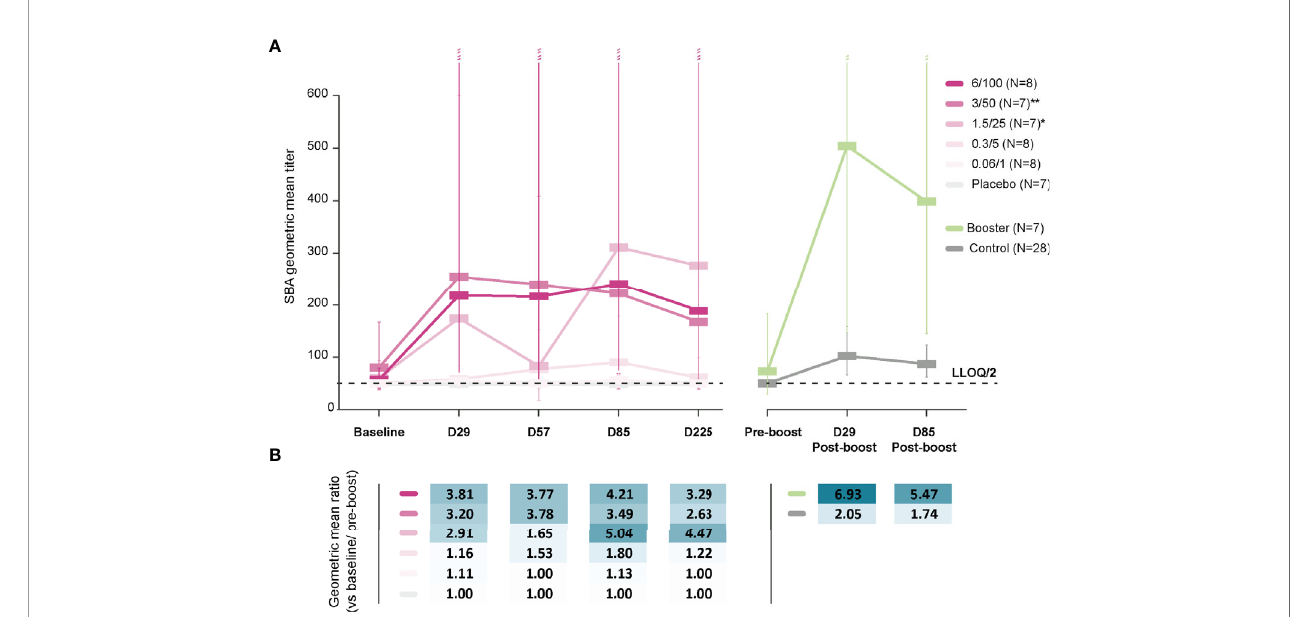
FIGURE 3 | SBA geometric mean titers (A) and within-group geometric mean ratios (B) . LLOQ, lower limit of quanti fi cation; SBA, serum bactericidal activity; Baseline, day of administration of the fi rst dose in the parent study; D29, 28 days post-dose 1; D57, 28 days post-dose 2; D85, 28 days post-dose 3; D225, 6 months post-dose 3; Pre-boost, day of administration of the booster dose (Booster)/vaccine dose (Control) in the extension study; D29 Post-boost; 28 days following booster dose (Booster)/vaccine dose (Control); D85 post-boost, 3 months after the booster dose (Booster)/vaccine dose (Control); N, maximum number of participants with available results; 0.06/1, group receiving 1790GAHB formulation with 0.06 µg O antigen (OAg) and 1 µg protein; 0.3/5, group receiving 1790GAHB formulation with 0.3 µg OAg and 5 µg protein; 1.5/25, group receiving 1790GAHB formulation with 1.5 µg OAg and 25 µg protein; 3/50, group receiving 1790GAHB formulation with 3 µg OAg and 50 µg protein; 6/100, group receiving 1790GAHB formulation with 6 µg OAg and 100 µg protein; Placebo, group receiving placebo; Booster, group receiving a booster 1790GAHB dose (1.5/25 µg OAg/protein) 2 – 3 years after primary vaccination; Control, placebo recipients (from the parent study) and vaccine-naïve participants (newly enrolled in extension study) receiving one dose of 1790GAHB (1.5/25 µg OAg/protein). *N=4 at D57 and N=6 at D85, D225. **N=6 at D57, D85, D225. Error bars depict 95% con fi dence